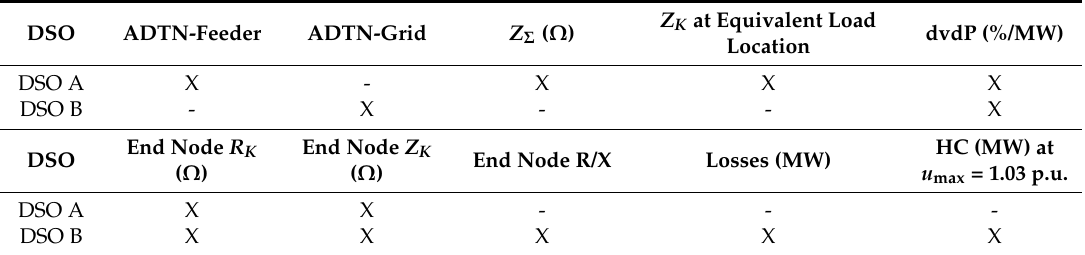
Table 2. Parameters of each DSO following a Weibull distribution marked with X (significance interval: